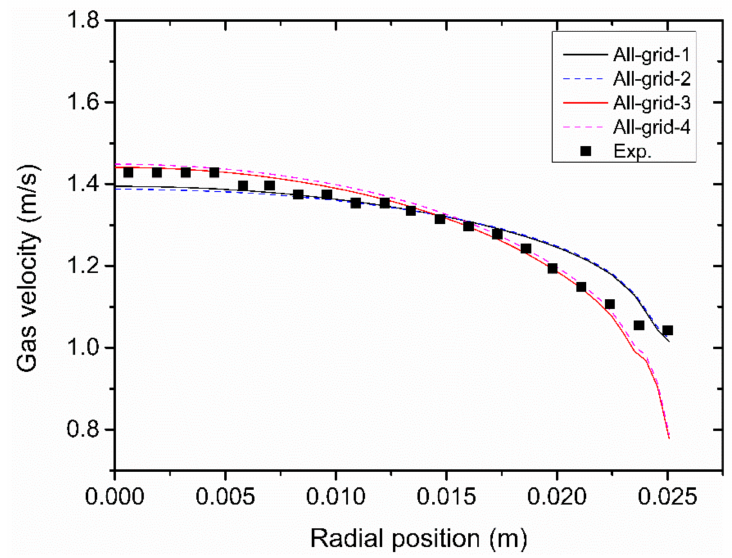
Figure 3. Calculation results of different partitioning schemes.